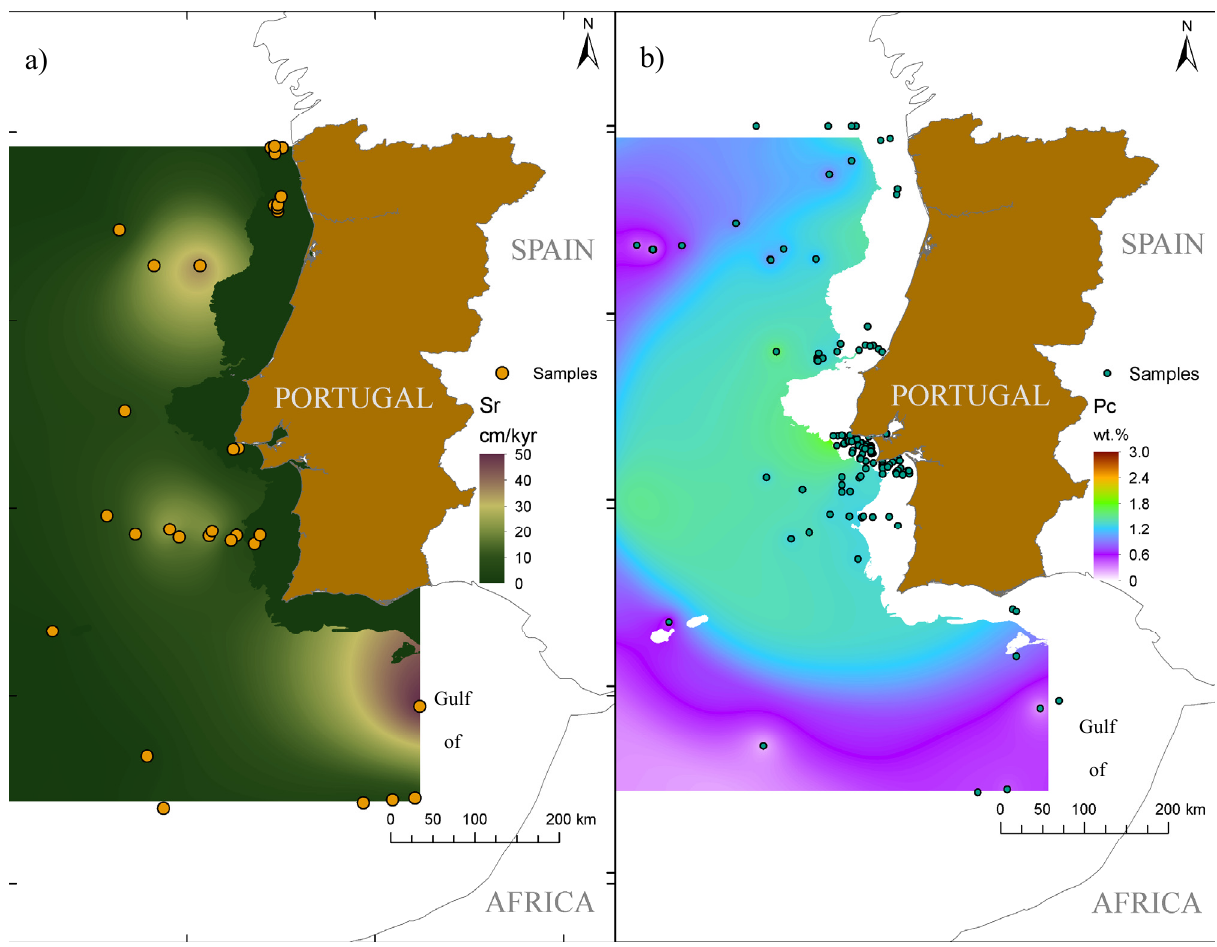
Figure 5. ( a ) Sedimentation rate raster dataset map; ( b ) Particulate Organic